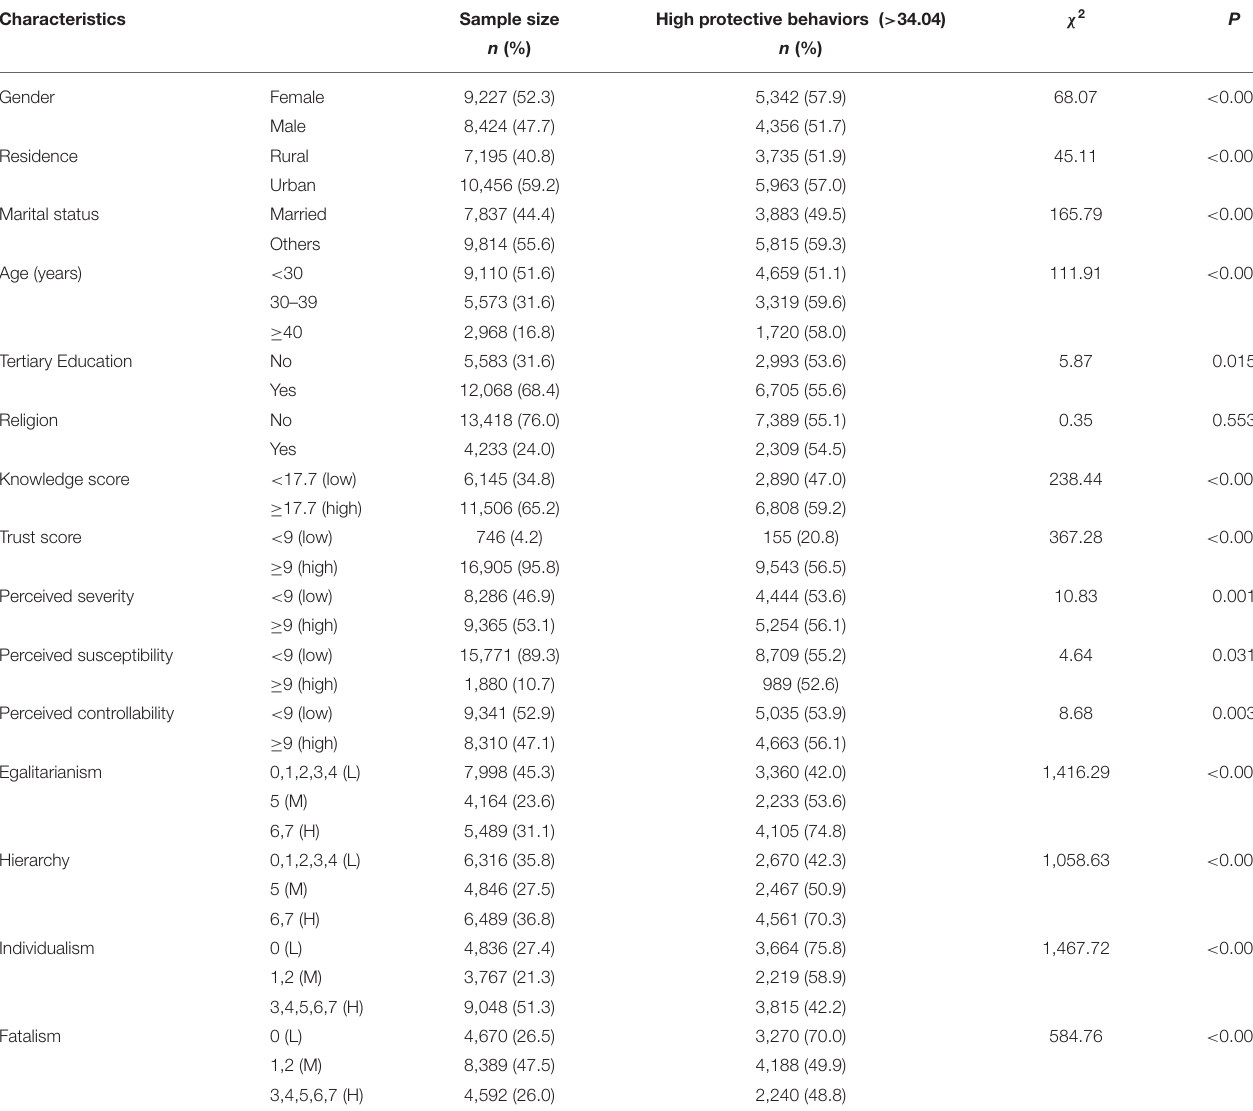
TABLE 1 | Characteristics of study participants ( n = 17,651).